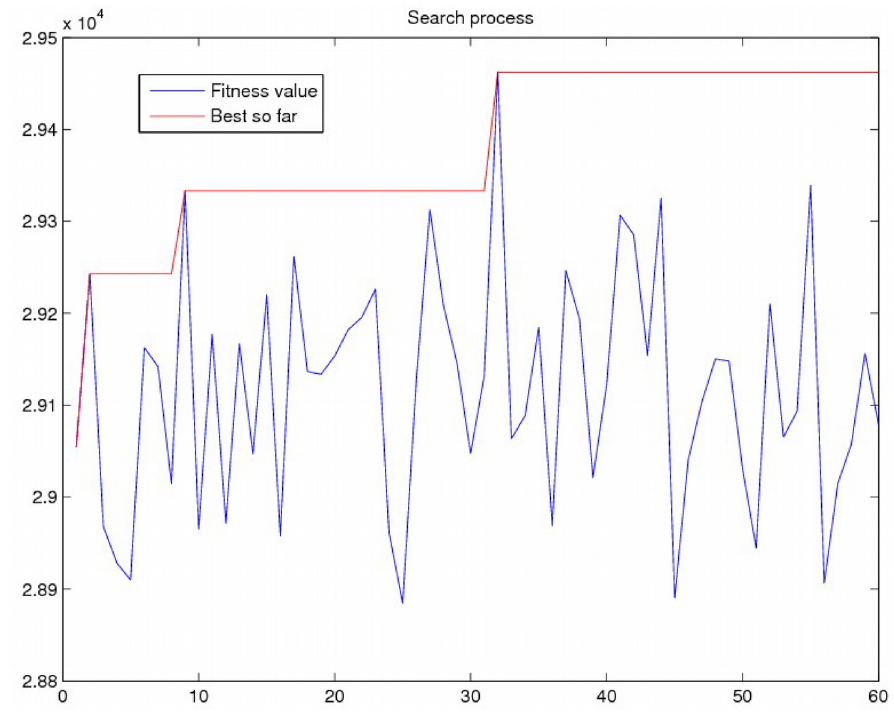
Figure 2. Optimal solution layout (Evolutionary process of the proposed GA approach). Here X-axis denotes the number of generations and Y-axis denotes the fitness function